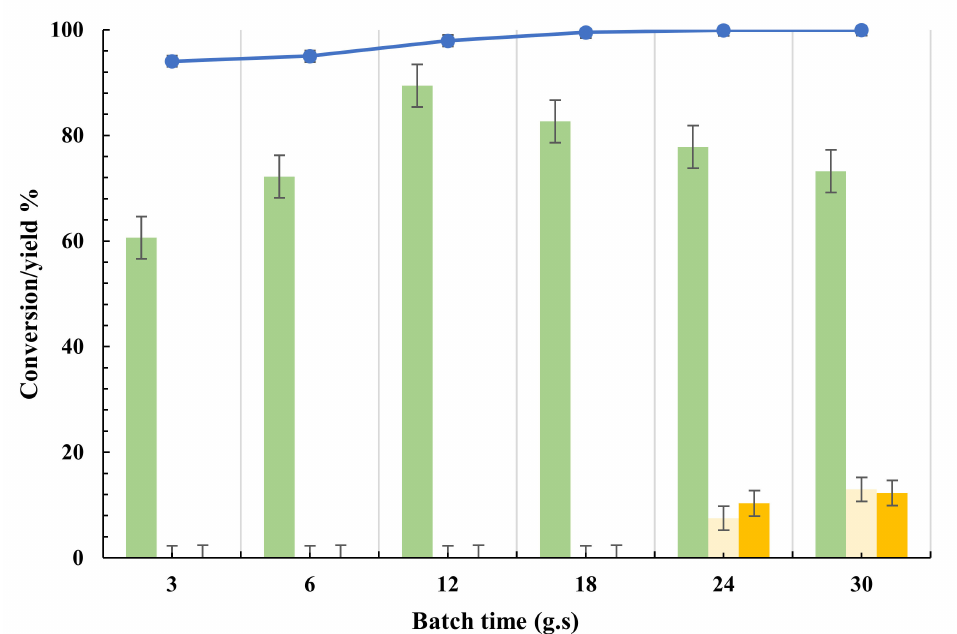
Figure 1. The effect of reaction batch time on product distribution via MW for fructose dehydration. Reaction conditions: MW via the standard power mode, 160 ◦ C, 10 mg MIL-101(Cr)-SO 3 H(3) ([H + ] 0.009 mmol), 160 ◦ C, 3 mL DMSO/acetone (70:30), catalyst/substrate = 0.3. ( — ) denotes fructose conversion %, ( (cid:4) ) denotes 5-HMF yield %, ( (cid:4) ) denotes FA yield %, and ( (cid:4) ) denotes LA yield %. Error bars represent a 95% confidence